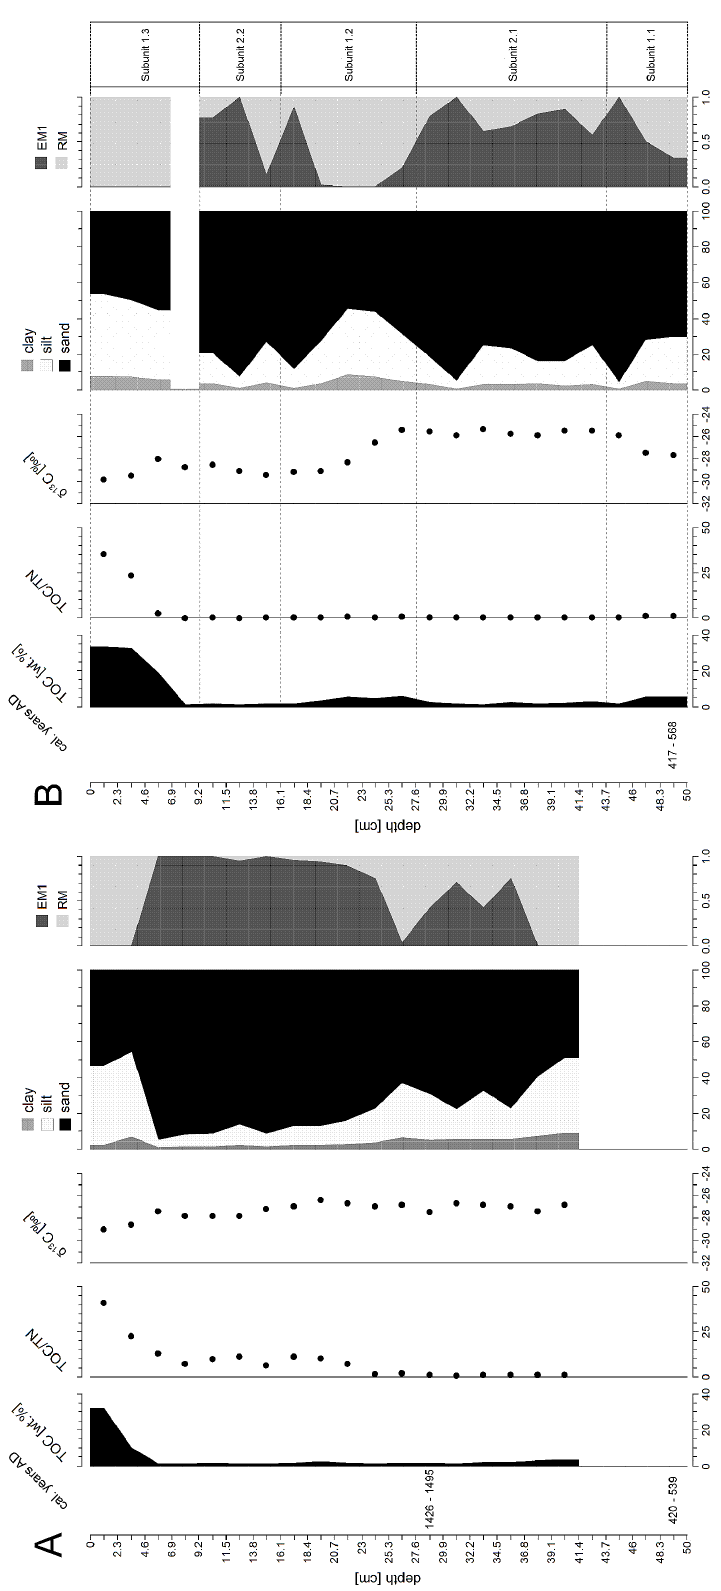
Fig. A2. Summary plot of organic matter (TOC, TOC/TN) and granulometric characteristics (endmember scores and grain-size distribution) from sections A and B. The granulometric parameters for Section B, 9.2cm to 6.9cm, were not